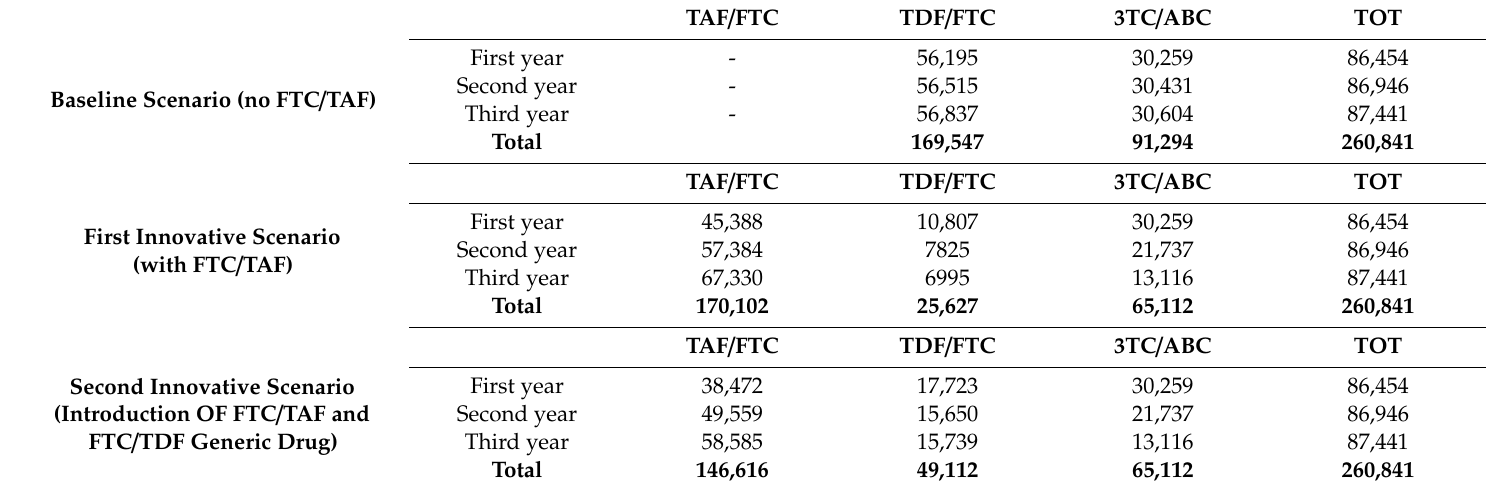
Table 6. Population considered in the Budget impact analysis. Source: data gathered by